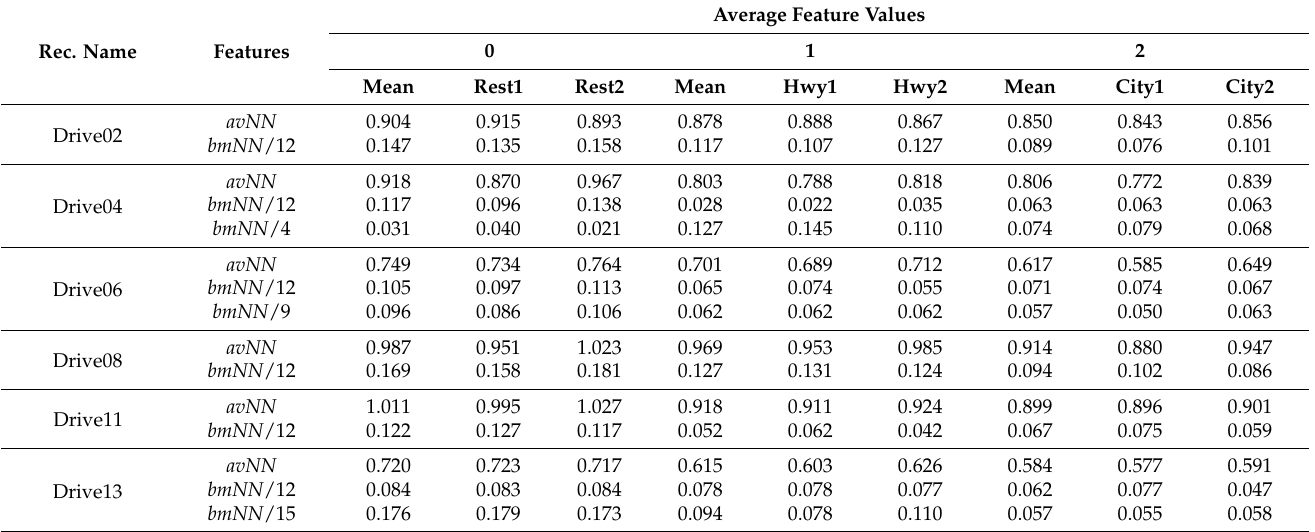
Table 3. Average values of avNN and bmNN for different driving sections of Drive02 \ 04 \ 06 \ 08 \ 11 \